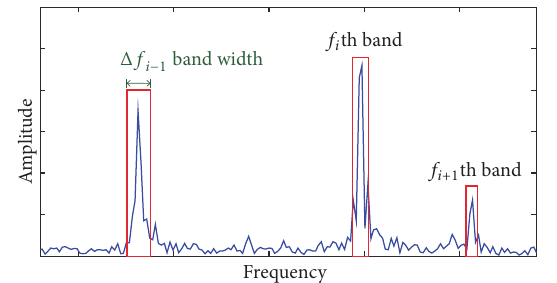
Figure 4: Illustration of the proposed comb filter.